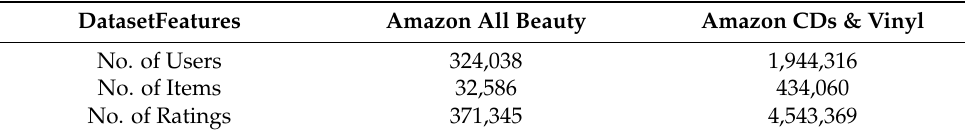
Table 9. The main features for the two Amazon datasets.